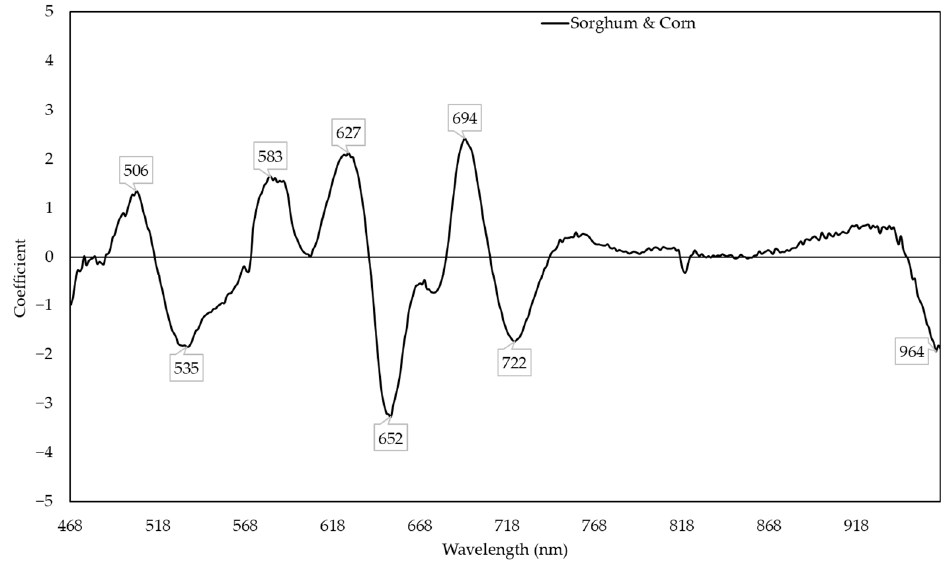
Figure 3. Coefficient in models predicting the relative water content with the responses of sorghum and corn.